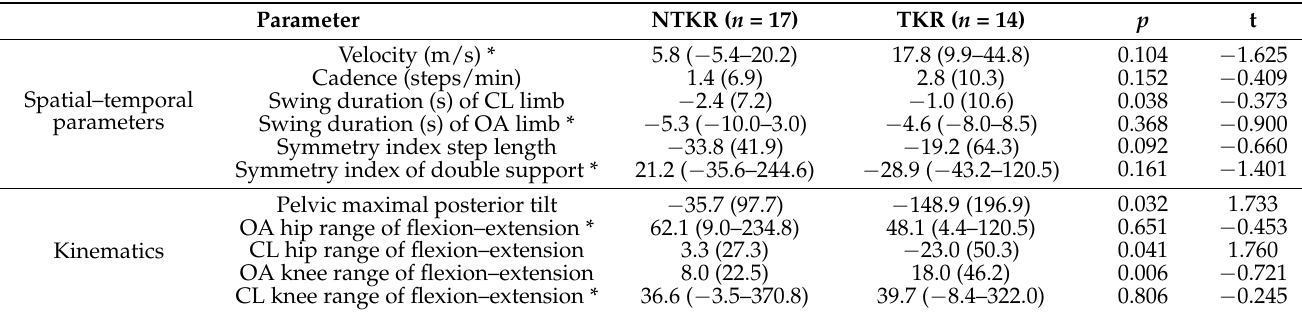
Table 2. Spatiotemporal and kinematics data of the lower limbs of the unperturbed gait calculated by X [ % ] = X Follow − up − X Baseline · 100. Numeric values are presented as the average and standard deviation. X Baseline